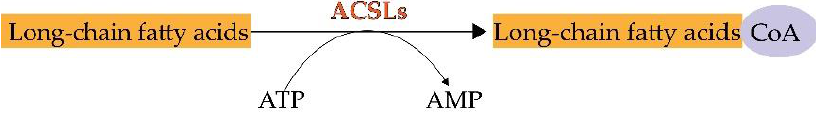
Figure 1. The chemical reaction of ACSLs.